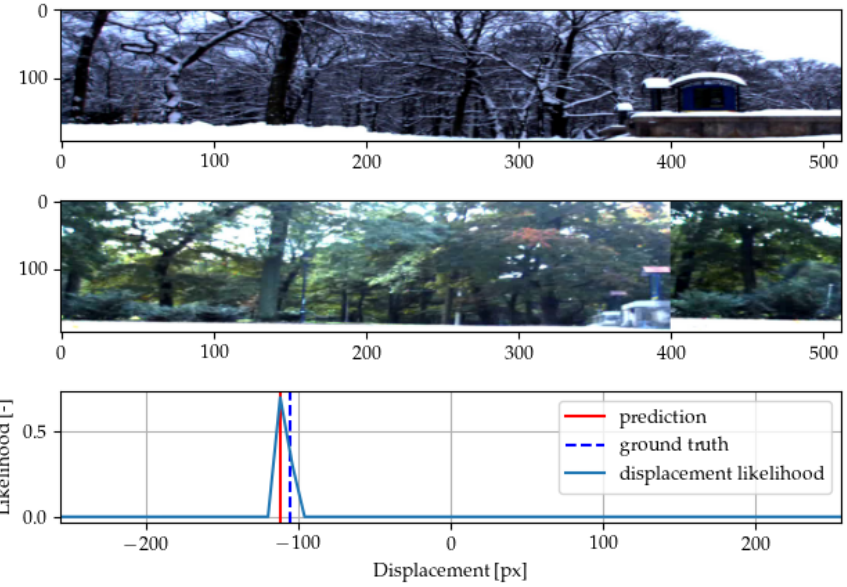
Figure 4. An example of the method correcting the horizontal alignment on an image pair from the Stromovka dataset used in [15]. Two images of the same scene are given to the network for alignment. There is visible shift (predicted by the network) with the roll padding in the bottom image. The likelihood of different potential displacement as outputt by the network is shown in the last diagram. In this example, the images are